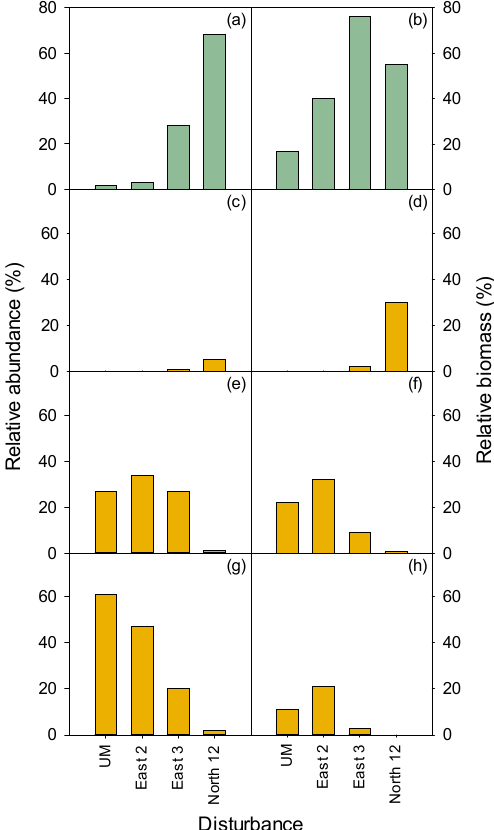
Figure 5. The Menziesia ferruginea (MEFE) habitat type phase 30 years after disturbance and the relative abundances (%) for shrubs of high stature ( a ) Alnus viridis ssp. sinuata and ( c ) Salix scouleriana ; medium stature ( e ) Menziesia ferruginea ; and low stature ( g ) Vaccinium membranaceum , and their respective relative biomass values (%), ( b , d , f , h ). Note: N-fixing shrubs in green; x-axis values progress from undisturbed forest (left) to the highest severity disturbance (right); see Table 1 for disturbance category descriptions.